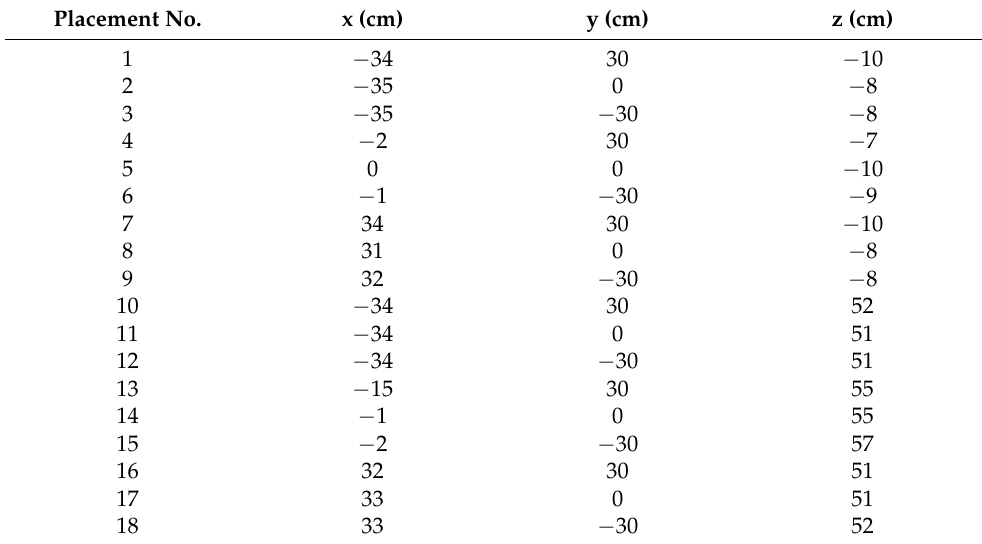
Table 2. PD source coordinates.